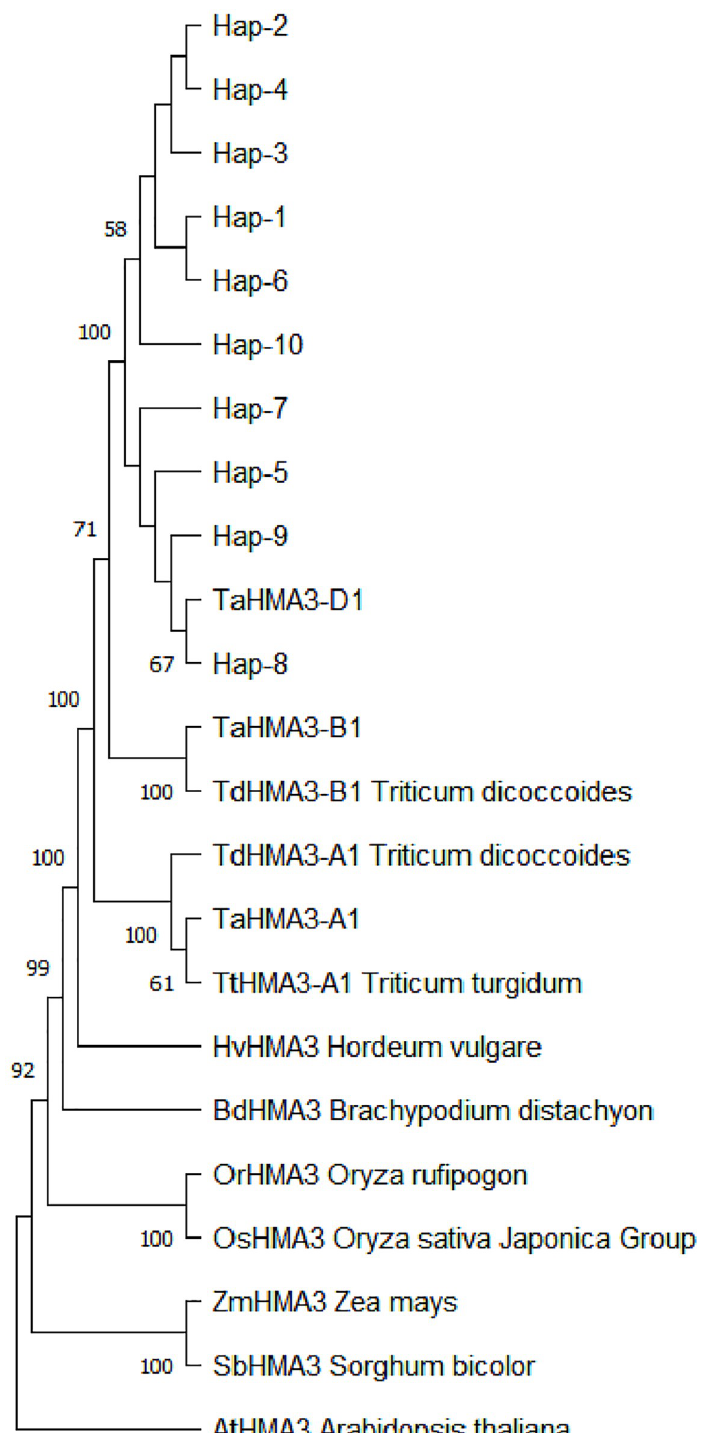
Fig 3. Phylogeny of A . thaliana , Brachypodium, rice, maize, barley, bread wheat cv. ‘Chinese Spring’, tetraploid wheat and Ae . tauschii HMA3 homoeologs obtained using the neighbor-joining method. Only bootstrap values (%) > 50%, as calculated from 1,000 replicates, are